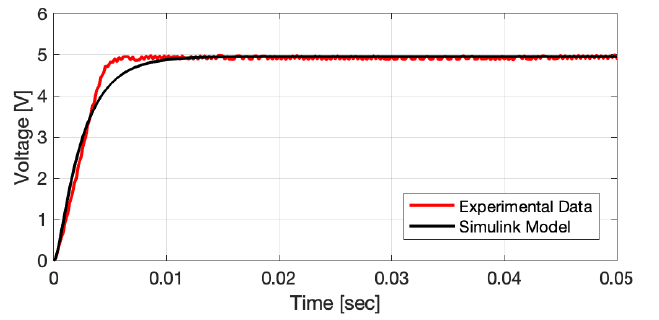
Figure 25. Output voltage of the Simscape model against the real optimized converter in nominal conditions.